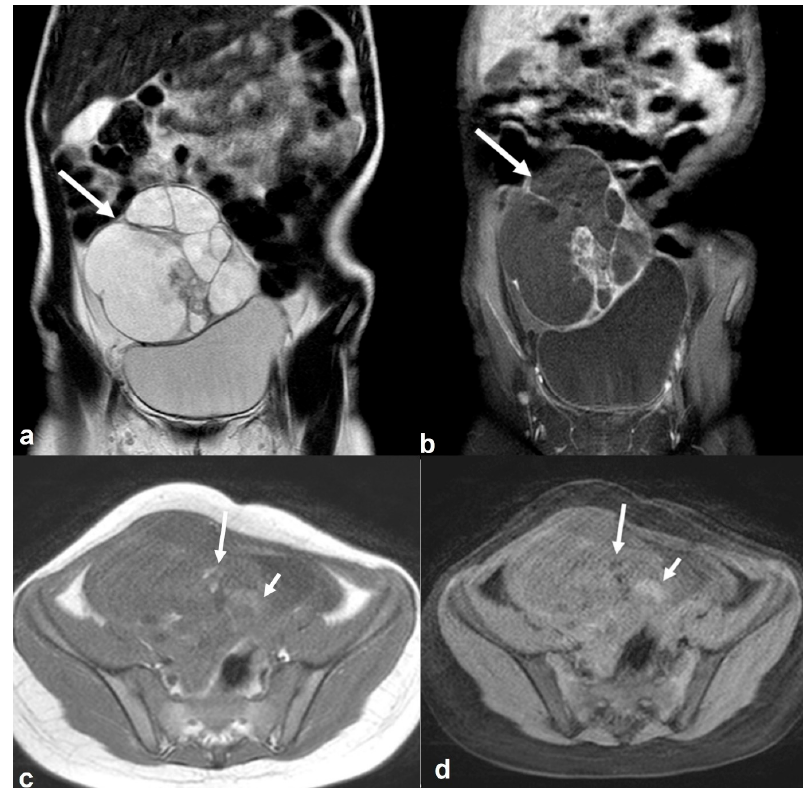
Figure 18. Immature teratoma in a 7-year-old girl. Coronal T2 weighted image ( a ) shows a large cystic right-sided pelvic mass (white arrow) with internal septations and smaller solid components which are enhanced on the T1 weighted FS CE image (( b ), white arrow). Axial T1 weighted image ( c ) shows tiny foci of high signal intensity (long arrow) with signal loss on the T1 weighted FS image (( d ), long arrow). Note also a few hemorrhagic foci with high T1 signal intensity on both T1 weighted images (short arrows in ( c , d )). Tip: Calcifications may be seen in mature or immature teratoma, Brenner tumor, and less commonly, fibrothecoma of the ovary.